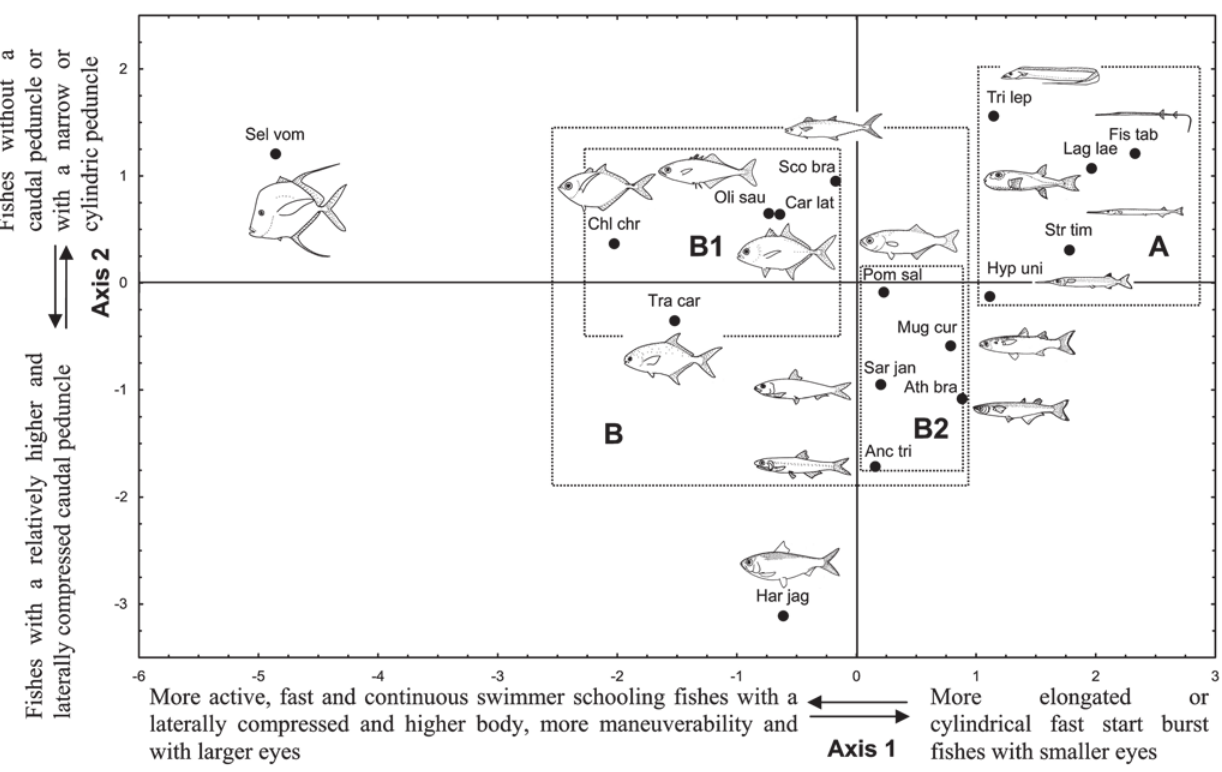
Fig. 2. Distribution of the 17 nektonic fish species in ecomorphological space. Ordination is by the first two axes of PCA (cumulative % of variance = 73) (see Table 5). Anc tri = Anchoa tricolor ; Ath bra = Atherinella brasiliensis ; Car lat = Caranx latus ; Chl chr = Chloroscombrus chrysurus ; Fis tab = Fistularia tabacaria ; Har jag = Harengula jaguana ; Hyp uni = Hyporhamphus unifasciatus ; Lag lae = Lagocephalus laevigatus ; Mug cur = Mugil curema ; Oli sau = Oligoplites saurus ; Pom sal = Pomatomus saltatrix ; Sar jan = Sardinella janeiro ; Sco bra = Scomberomorus brasiliensis ; Sel vom = Selene vomer ; Str tim = Strongylura timucu ; Tra car = Trachinotus carolinus ; Tri lep = Trichiurus lepturus . There is no scale among the fishes (see Table 2 for standard length range) (illustrations: Alexandre C.